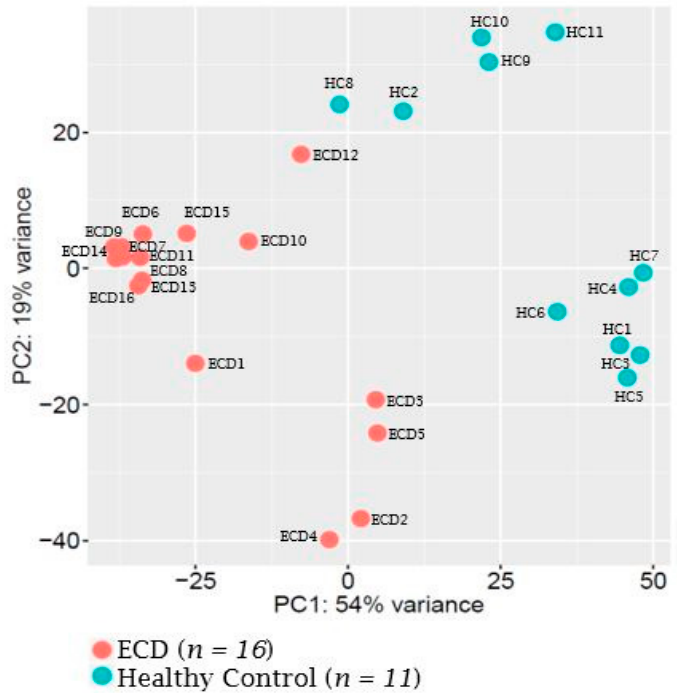
Figure 1. Differential microRNA expression in plasma samples of ECD patients and healthy controls (HC). Principal component analysis (PCA) mapping of NanoString nCounter Human miRNA expression assay. PCA analysis confirmed a differential expression pattern between plasma samples of ECD patients (red) and HC (blue).